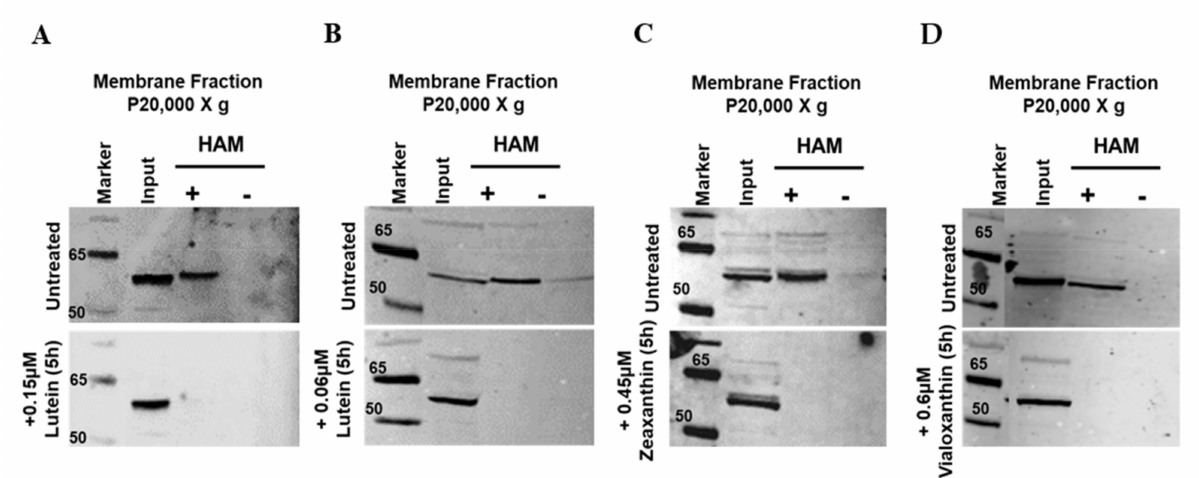
Figure 2. mBCO2 loses its palmitoylation in the presence of substrate. The palmitoylation status of mBCO2 protein was ana- lyzed by Acyl-RAC assay in the presence of different substrates: ( A ) 0.15 µ M lutein; ( B ) 0.06 µ M lutein; ( C ) 0.45 µ M zeaxan- thin; and ( D ) 0.6 µ M violaxanthin. Equal amounts (~50 µ g) of the total (indicated as “input”) and eluted protein from control (indicated as “-”) and hydroxylamine (HAM)-treated (indicated as “+”) were subjected to SDS-PAGE and immunoblotting. Western blot results are representative of three independent experiments as shown in the Supplementary